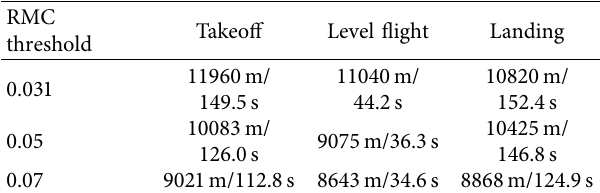
Table 10: Critical separation of different flight stages.